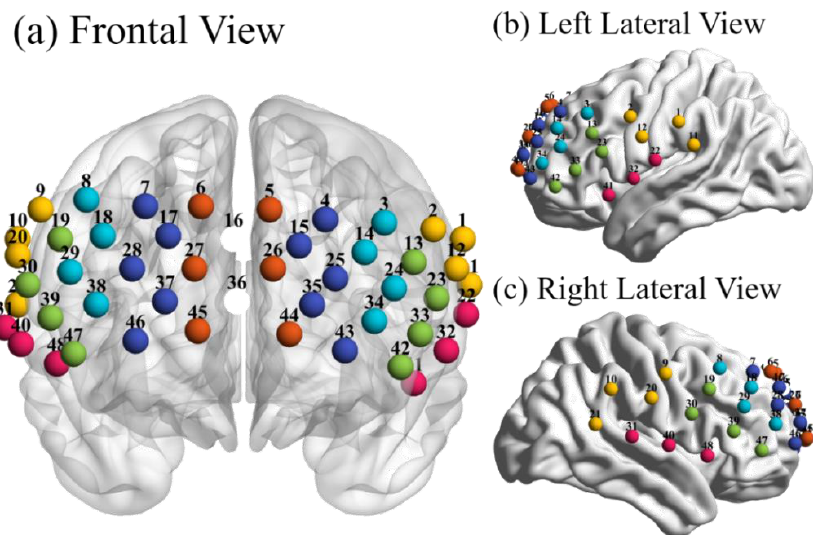
Figure 1. The arrangement of 48 measurement channels covering the prefrontal network of the brain: Frontal view ( a ), left and right lateral views ( b , c ). The anatomical positions included inferior frontal gyrus (IFG, green balls), middle frontal gyrus (MFG, light blue), superior frontal gyrus (SFG, dark blue), superior median frontal gyrus (SMFG, dark red), temporo-parietal junction (TPJ, yellow) and superior temporal gyrus (STG, pink). The figure was visualized via BrainNet Viewer [34]. The near-infrared light of three wavelengths (780 nm, 805 nm, 830 nm) was used at a sampling rate of 8.7 Hz. All participants were instructed to sit in a quiet room.